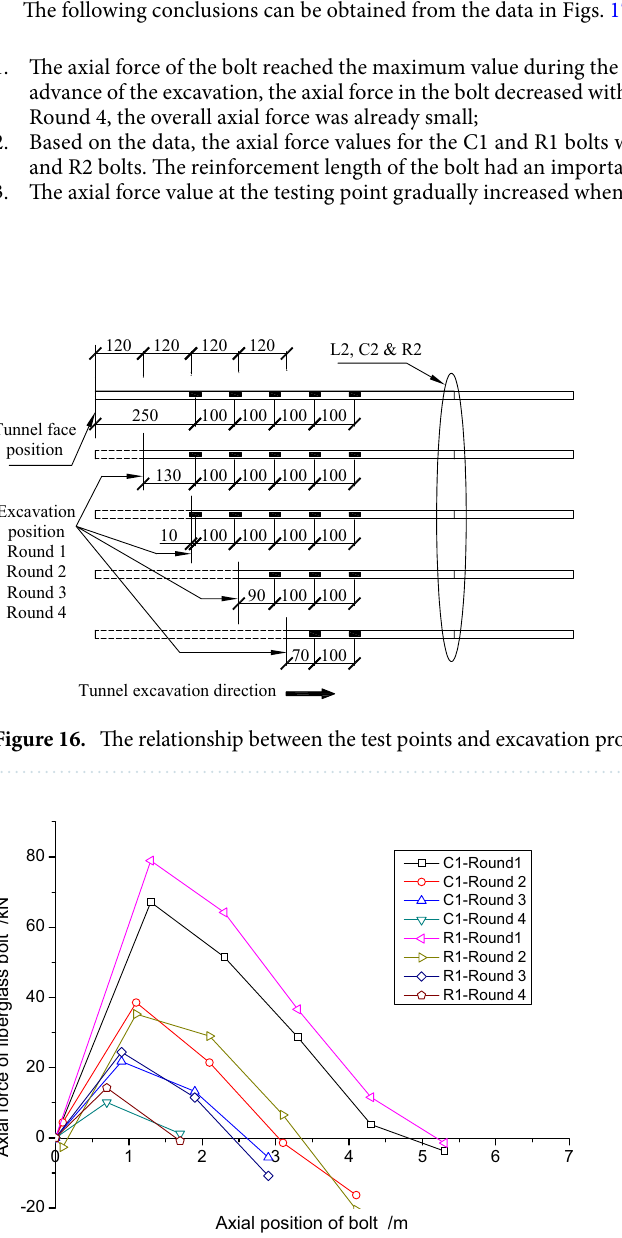
Figure 17. Axial force for C1 and R1